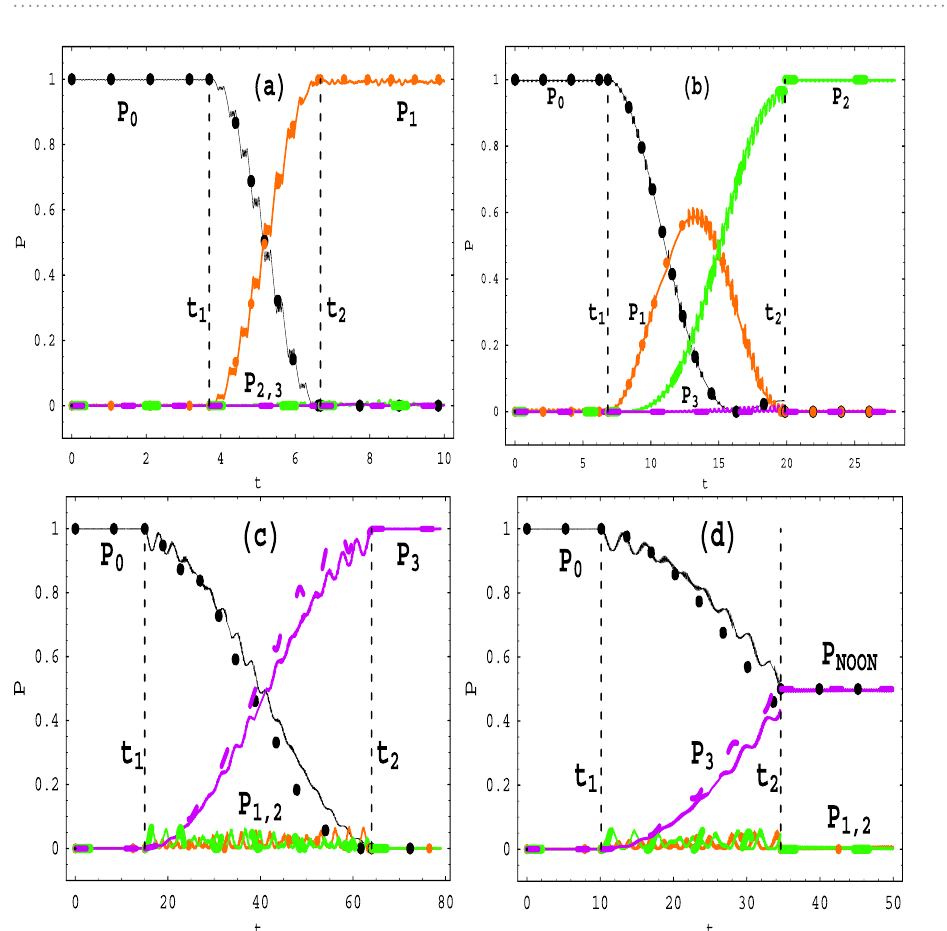
Figure 3. Time evolutions of the transition probabilities from the initial SLS | ψ 03 ( t ) 〉 to other final SLSs for the parameters ω = 20, Ω 0 = 1, n = 1, and ( a ) Ω 1 = 0.3, m = l = 1, ε 1 = 0 (in the time intervals ≤ <